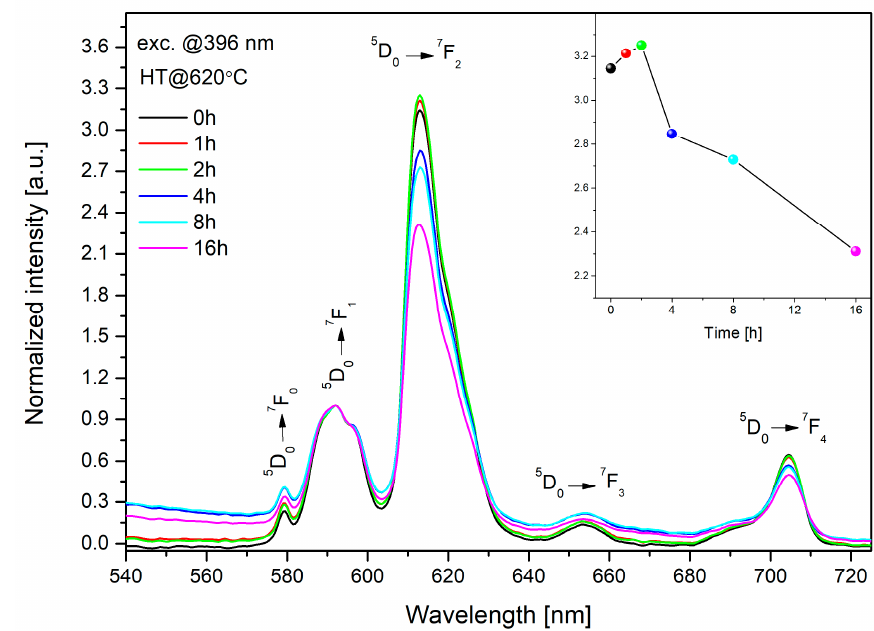
Figure 12. The characteristic of luminescence changes for 45S5 glass doped with Eu 3 + ions before and after heat treatment at 620 ◦ C. Asymmetry ratio of 45S5 bioactive glass doped with Eu 3 + (inset). The ratio between the electric dipole transition ( 5 D 0 → 7 F 2 ) and magnetic dipole transition ( 5 D 0 → 7 F 1 ) determines the local inversion symmetry in the vicinity of europium ions, as follows [14]: